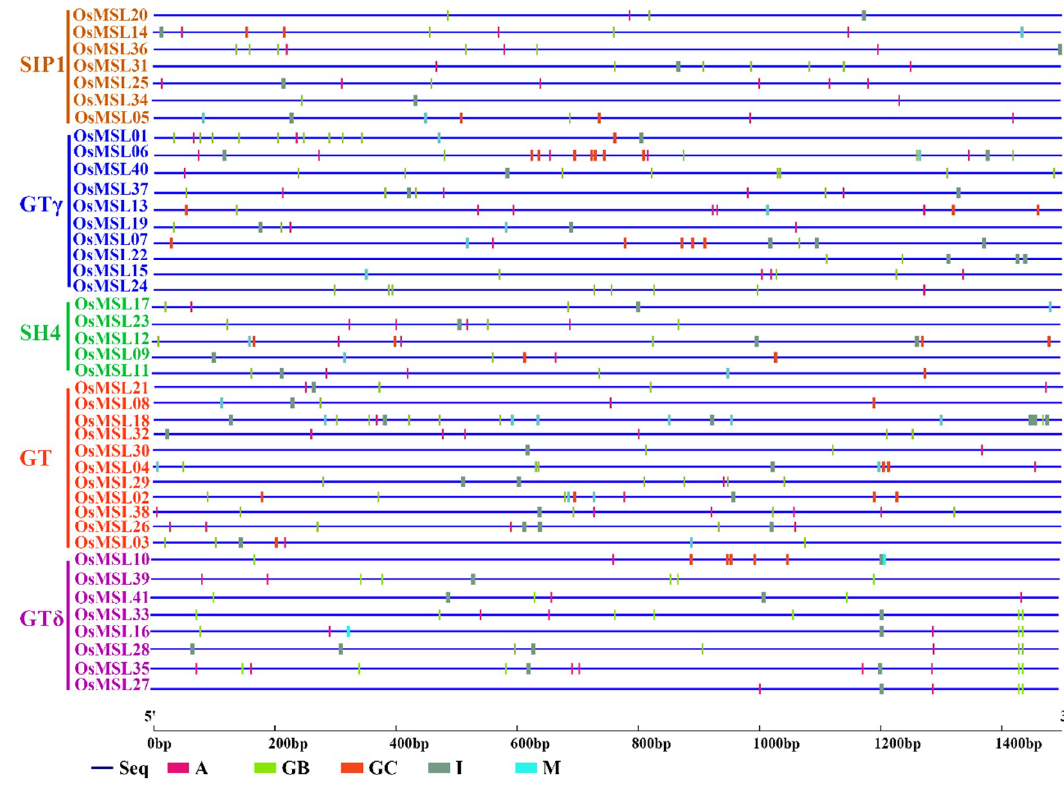
Figure 7. Predicted cis -elements in the promoter regions of the rice trihelix genes. All promoter sequences (−1500 bp) were analyzed. The trihelix genes are shown on the left side of the figure. The scale bar at the bottom indicates the length of promoter sequence. Green bar (GB): GATABOX element; purple bar (A): ACGTATERD1 element; red bar (GC): GT1CONSENSUS element; gray bar (I): INRNTPSADB element; blue bar (M): GT1GMSCAM4 element.